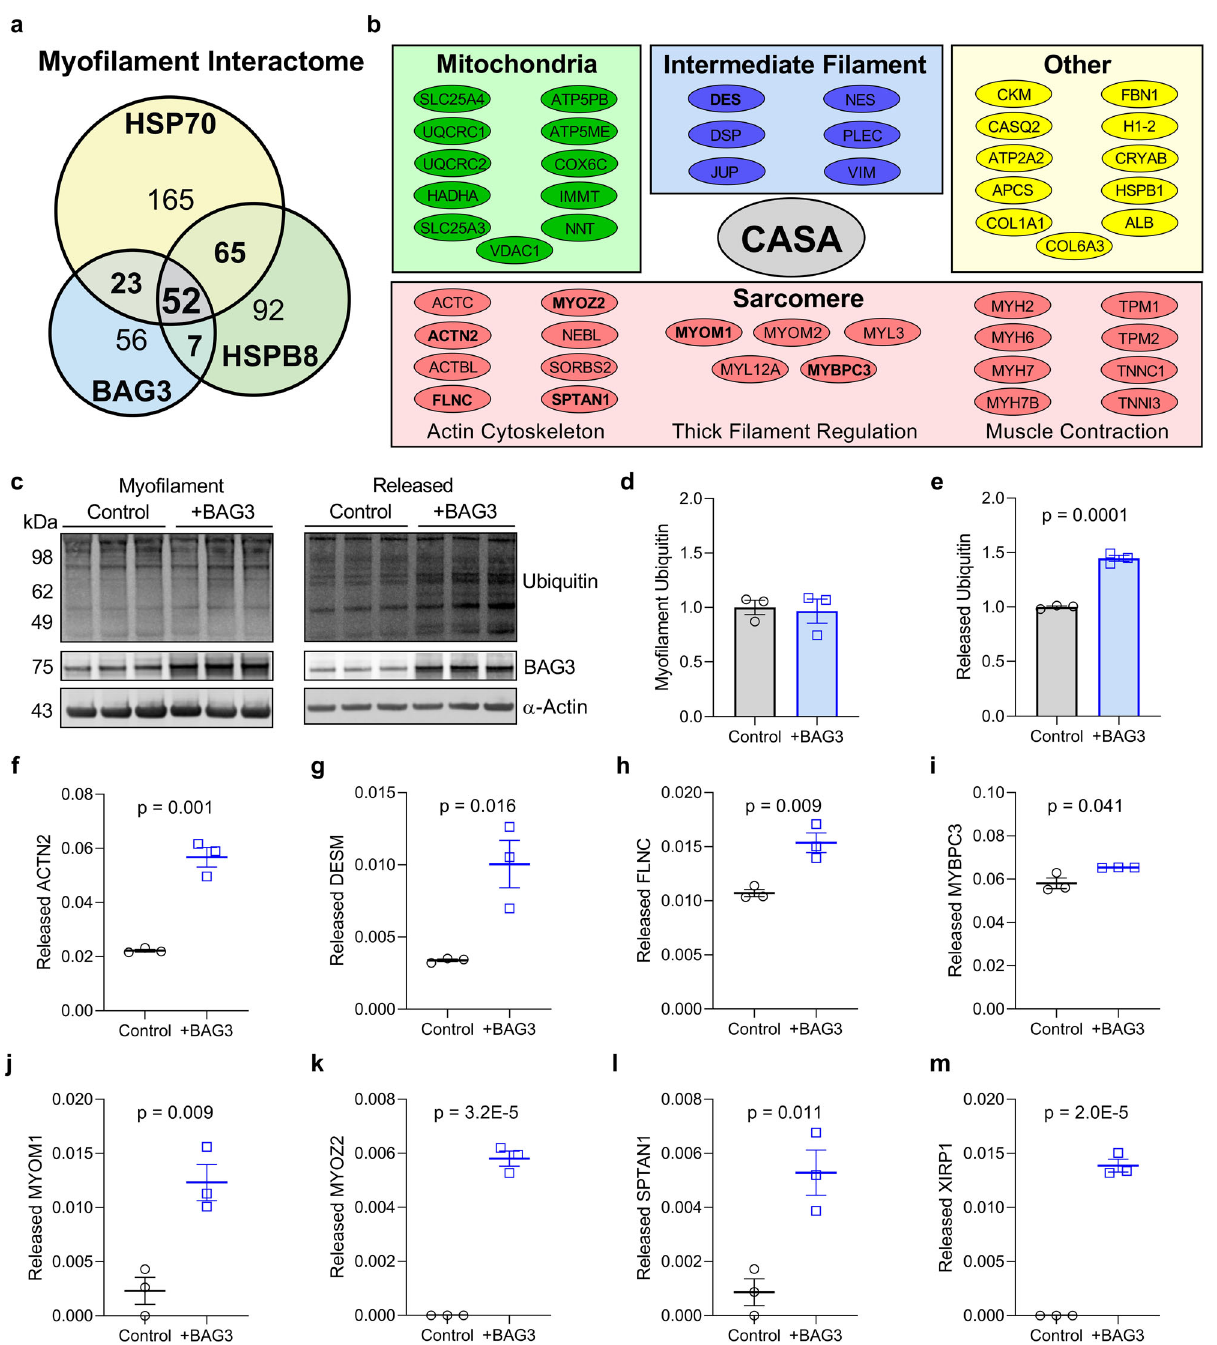
Fig. 6 Identi fi cation of the sarcomeric CASA clients in the human heart. a Quantitative Venn diagram of the BAG3, HSP70, and HSPB8 myo fi lament interactomes identi fi ed by bottom-up mass spectrometry of immunoprecipitated proteins. b List of the 49 shared proteins identi fi ed in the myo fi lament interactome of each CASA complex member; bold = previously identi fi ed CASA clients (FLNC) and new CASA clients identi fi ed in this study. c Western blot for myo fi lament ubiquitin and ubiquitinated proteins released from the myo fi lament in response to increased BAG3 expression; image is representative of 3 hearts/group. d, e Quantitative densitometry for myo fi lament ( d ) and released ( e ) ubiquitin normalized to α -actin; n = 3 control, 3 + BAG3. f – m Spectral count analysis of the eight sarcomere proteins identi fi ed by mass spectrometry to increase in the released protein fraction with increased BAG3 expression. For all, n = 3 control and 3 recombinant BAG3 treatment ( + BAG3), from the same 3 human LV samples. All data are presented as mean ± SEM and were analyzed by two-tailed t